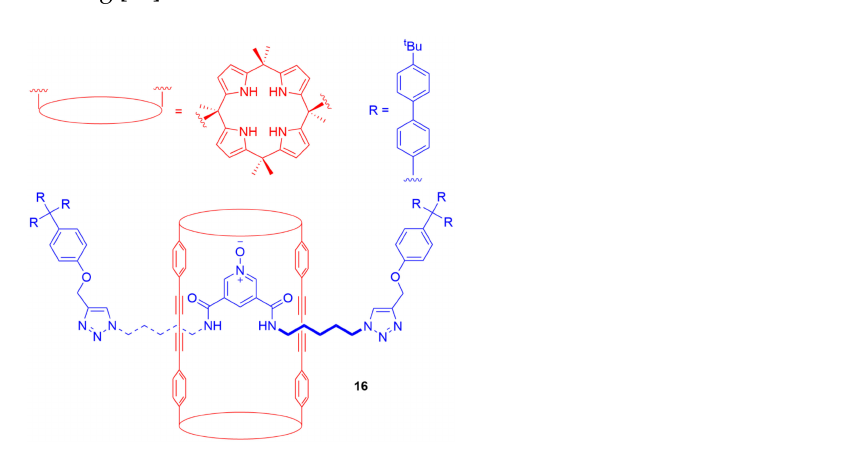
Figure 12. Ballester’s pyridine- N -oxide rotaxane 16 using a bis(calix[4]pyrrole)